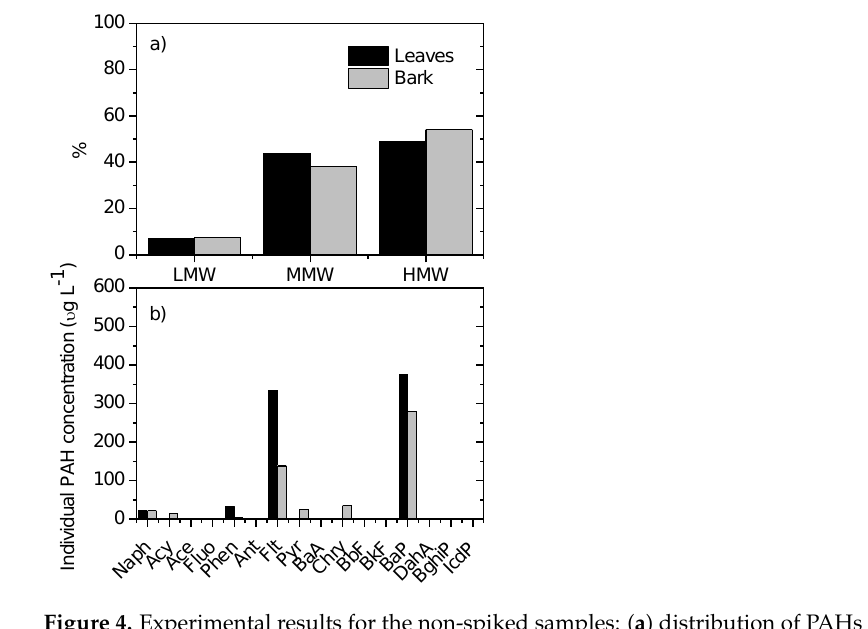
Figure 4. Experimental results for the non-spiked samples: ( a ) distribution of PAHs according to the molecular weight classification and ( b ) the individual PAH concentration.